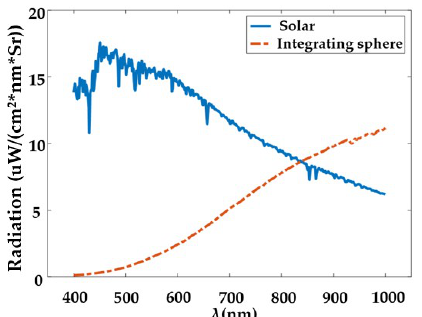
Figure 14. Spectral radiance curves of integrating sphere and solar.